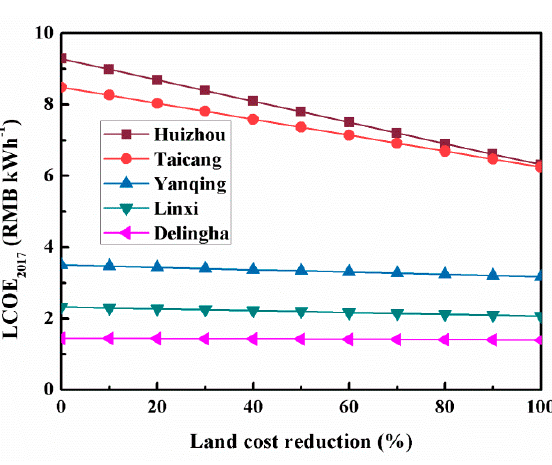
Figure 5. E ff ect of land cost on the LCOE for five di ff erent Figure 5. Effect of land cost on the LCOE for five different sites.